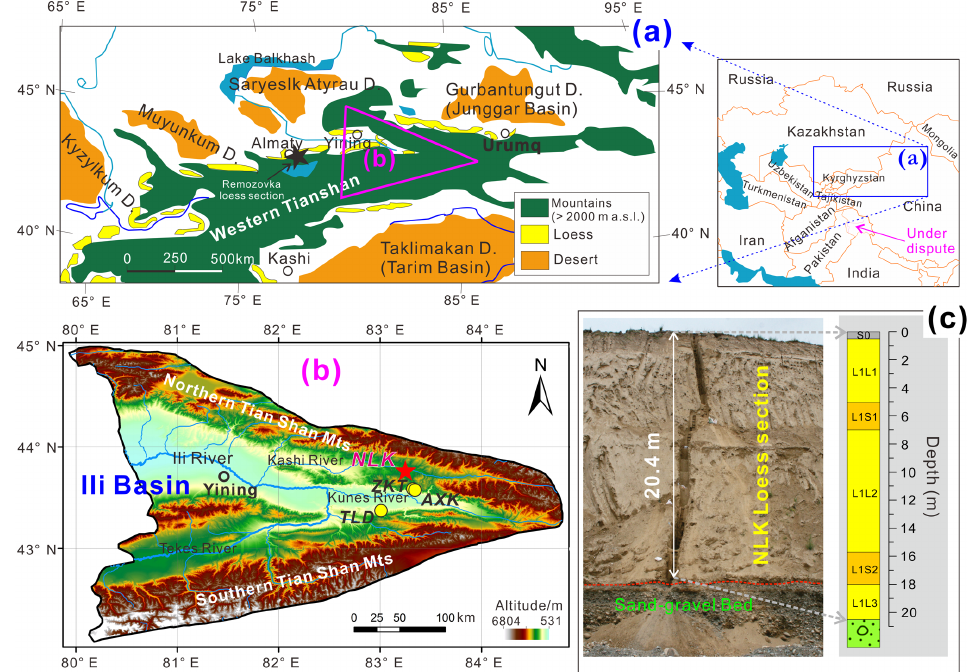
Figure 1. The location of study area and the photo of the Nilka (NLK)